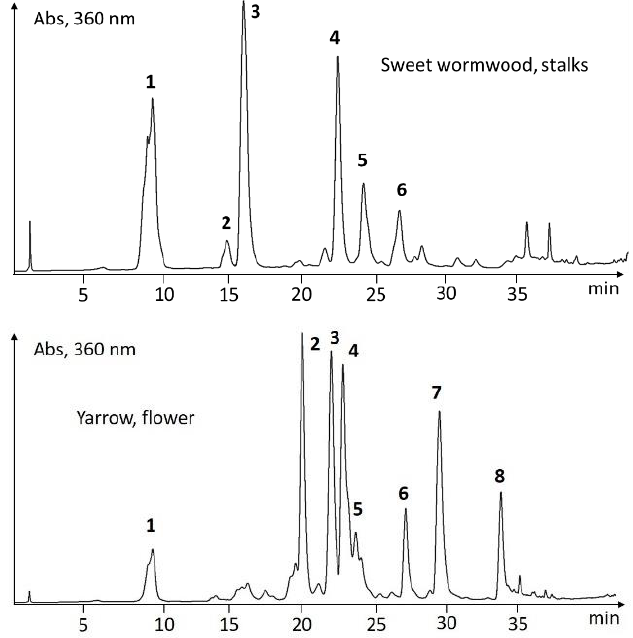
Figure 4. Chromatograms obtained by UHPLC-DAD of EtOH-extracts from nine herb species. Peaks are characterised according to Table 4, and peak numbers are restarted in each chromatogram.